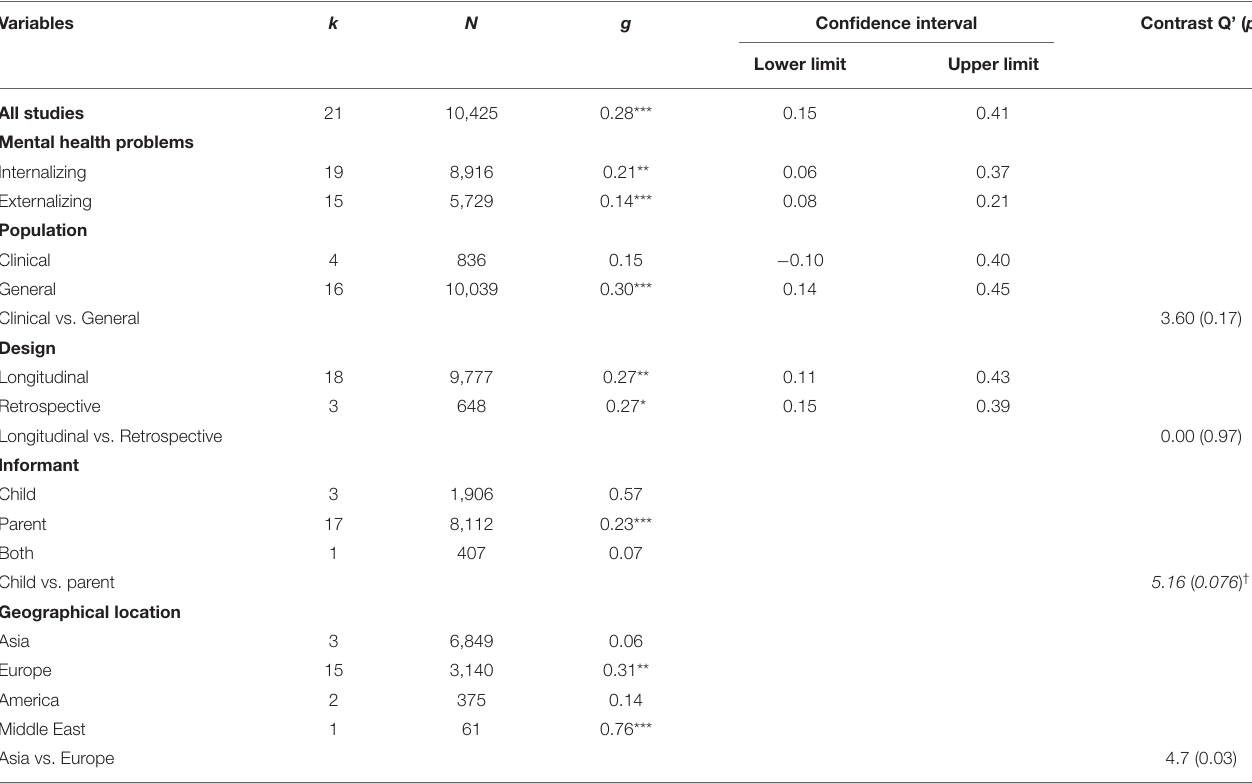
TABLE 3 | Subgroup analyses for mental health studies ( k =